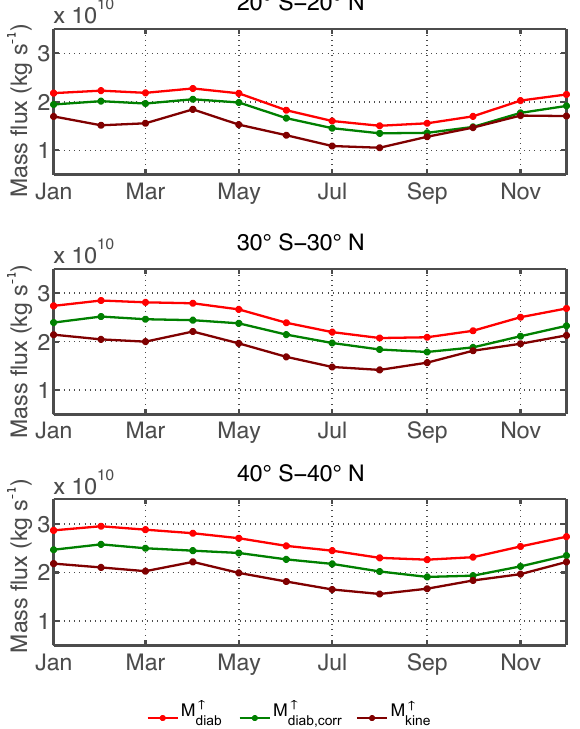
Figure 10. Annual variations of the monthly upward mass flux at the 380K surface, calculated from the ERA-Interim data. M ↑ M : diabatic mass flux calculated from the radiative heating diab , corr rates of ERA-Interim with and without the mass conservation cor- rection of the radiative heating rates, respectively. M mass flux calculated from the residual mean meridional circulation. All quantities are calculated and averaged over the years 2005 to 2008.